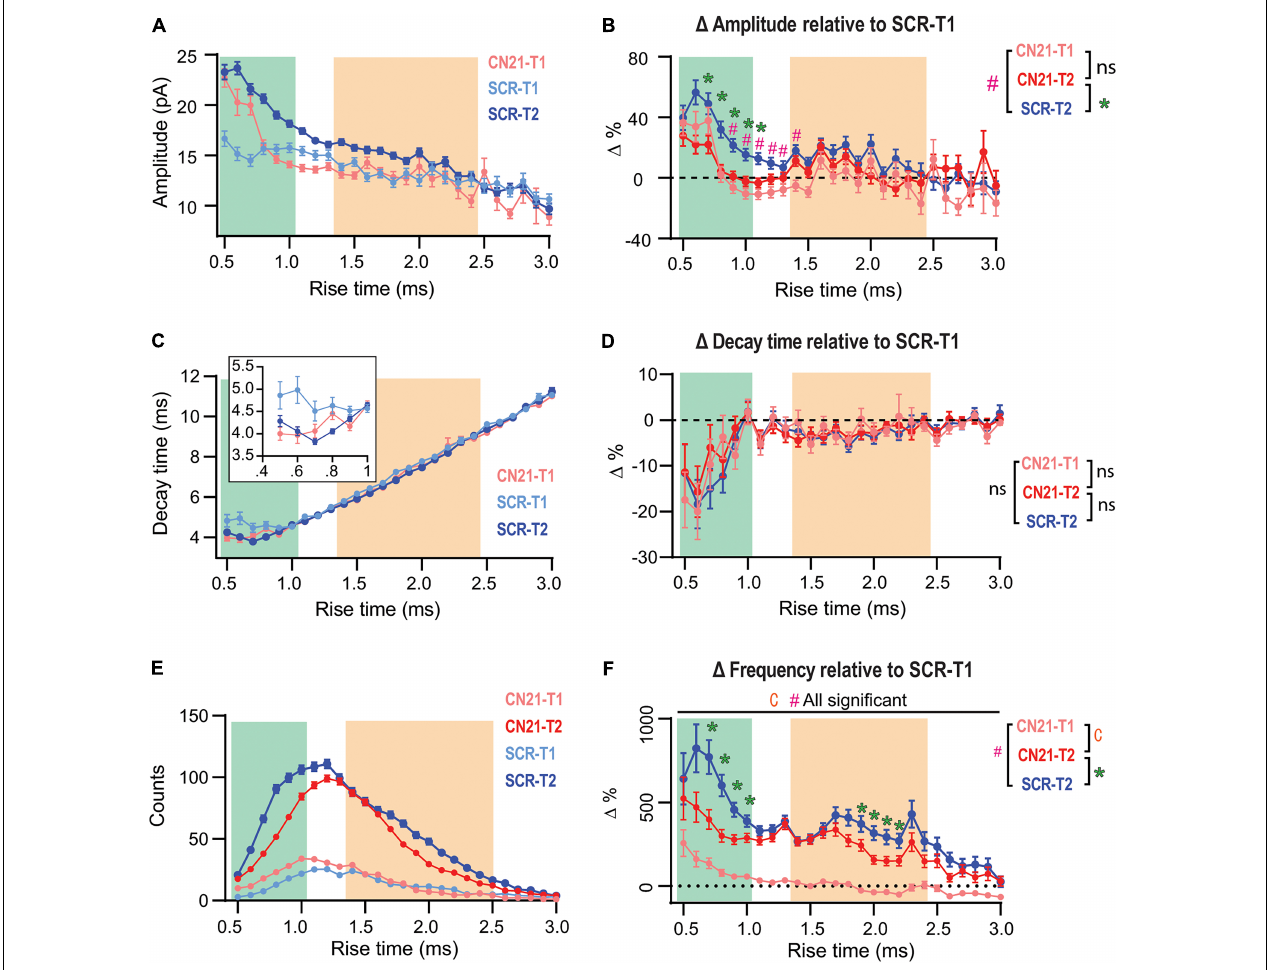
FIGURE 4 | Early CaMKII inhibition abolishes or occludes homeostatic adaptations in different groups of synapses. (A) Overlaid τ r -sorted mEPSC amplitude distributions for each temporal stage and condition. The curve for CN21 at T2 was omitted for simplicity. (B) Amplitude percent differences with respect to the SCR distribution at T1 (C) Same as panel (A) , for decay time. Inset, detail for fast-rising group. (D) Same as panel (B) , for decay time. (E) Superimposed event frequency distributions for each time interval and condition (same curves as in Figures 3H,J ; left). (F) Frequency increases with respect to SCR condition at T1. Same data as for Figure 3 . Bootstrap with weighted p -values (all panels). * p <